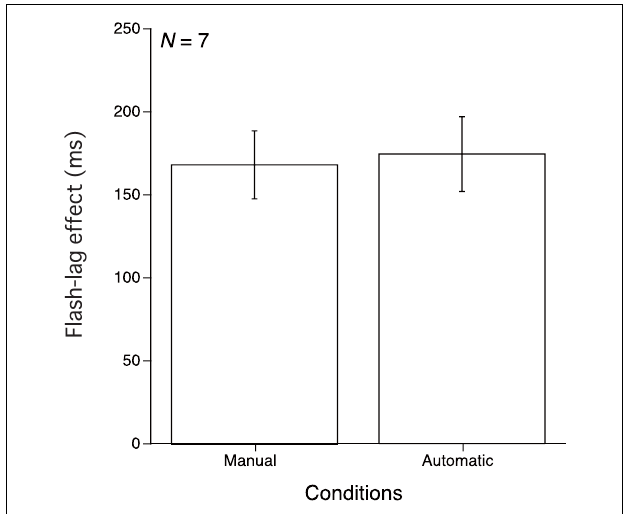
FIGURE 4 | Results of Experiment 3. Mean and SE of the 50% threshold for the two